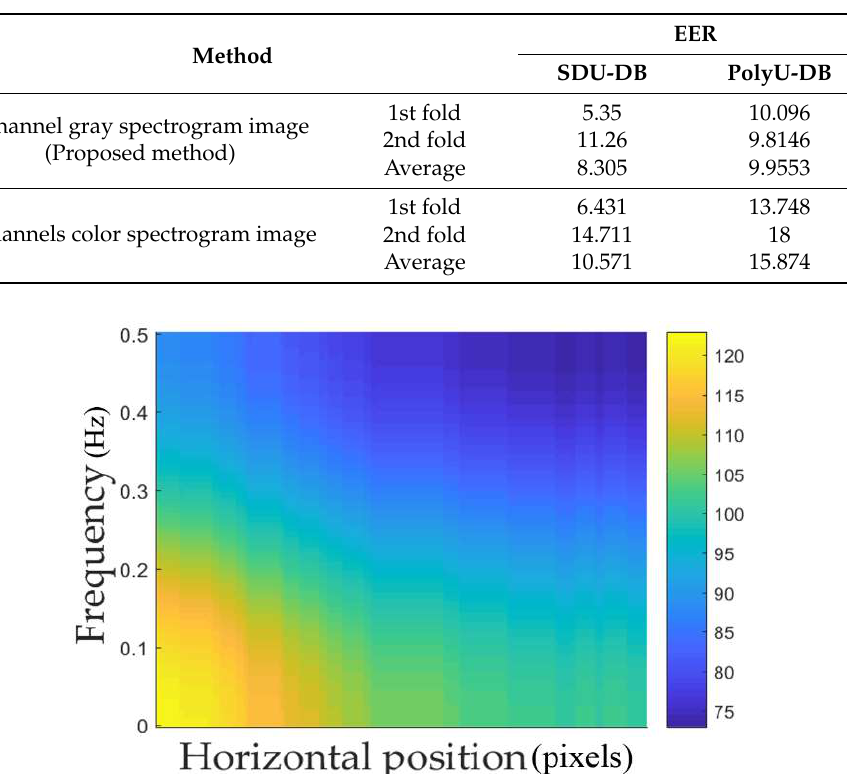
Table 7. Comparison of the accuracies of finger shape recognition according to one channel and three channel spectrogram images (unit: %).